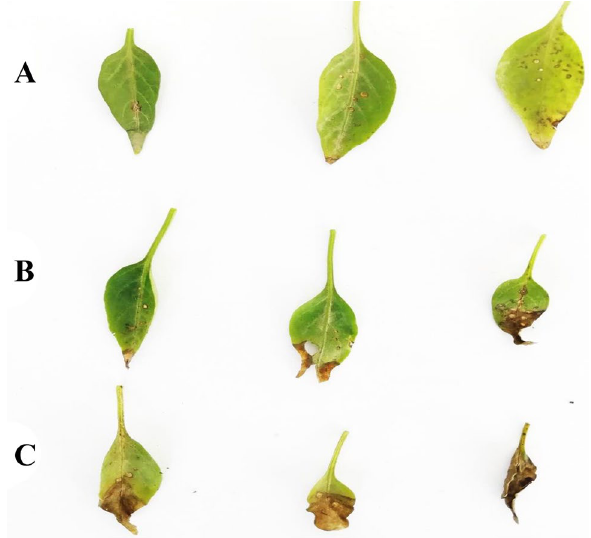
Figure 1. Leaves of chili plants showing disease symptoms in RSBNPs treated plants ( A ), FNPs treated plants ( B ) only soil-grown plants ( C ). In vitro inhibitory effect of rice straw biochar nanoparticles (RSBNPs) and fly ash nanoparticles (FNPs) on Xanthomonas campestris pv . vesicatoria.